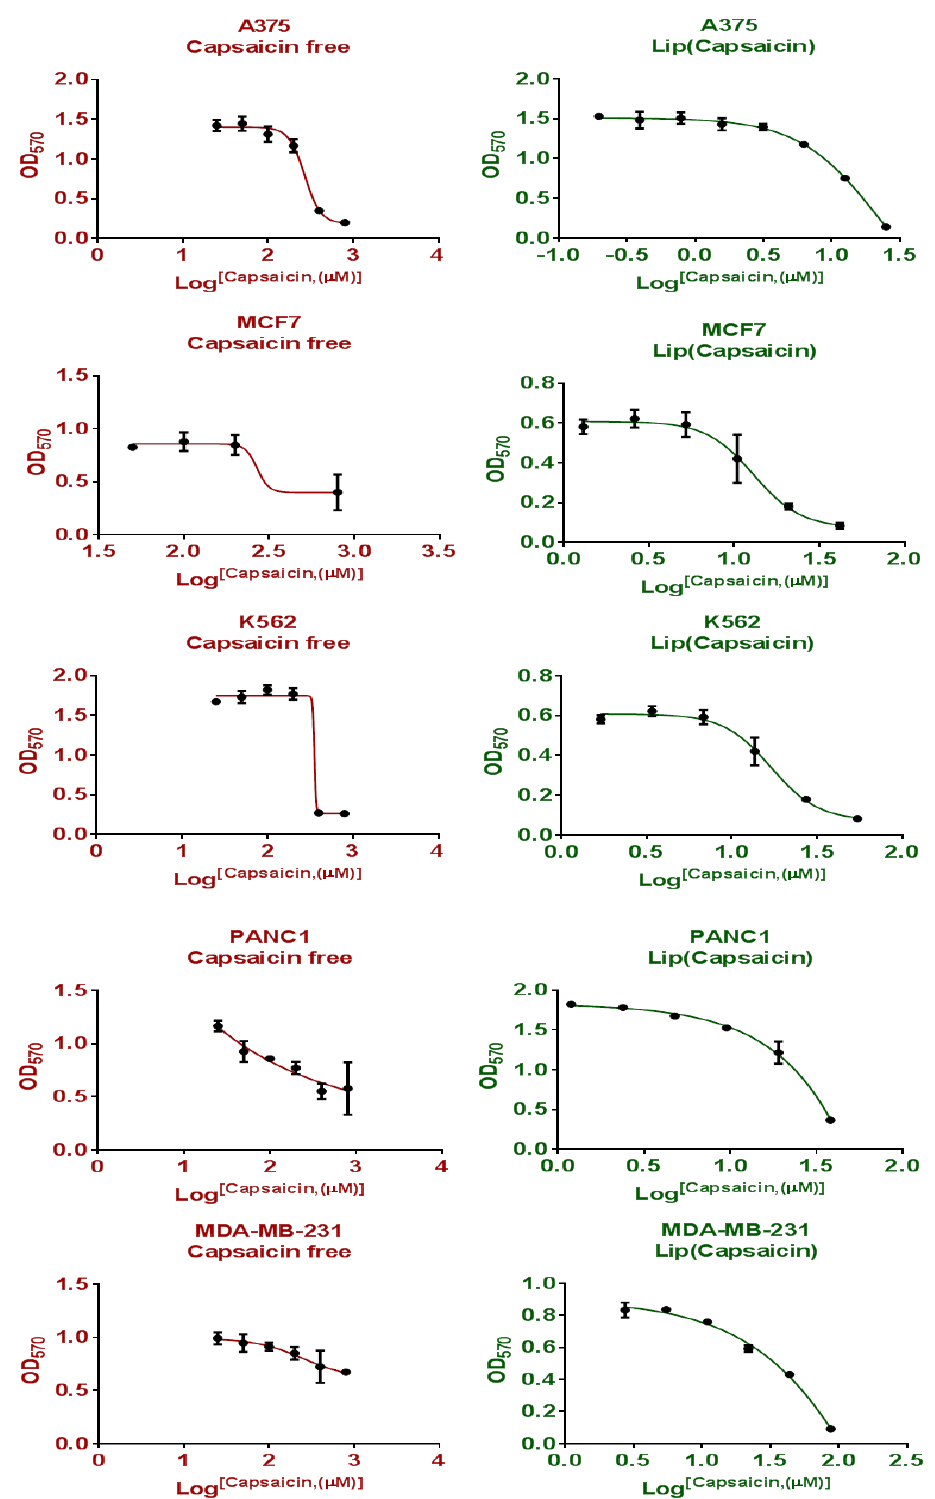
Figure 5. Cytotoxicity and the half maximal inhibitory concentration (IC 50 ) of CAP and CAP-loaded nanoliposomes against MCF7 human breast cancer cell line.